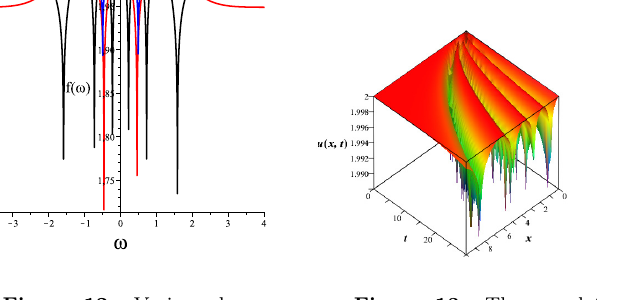
Figure 12. Various shape Figure 13. The complete functions of Equation (4.3) for the solution for the Gaussian noise for parameter set a = 0 . 1 ,λ = 55 value. Other ν = 1 / 2 ,n = 1 ,c 2 = 1 and c 1 = 0 parameters are for different λ values. Black, red and blue lines are for a = 1 ,λ = 25, a = 0 . 25 ,λ = 25, and a = 0 . 1 ,λ = 55, respectively.